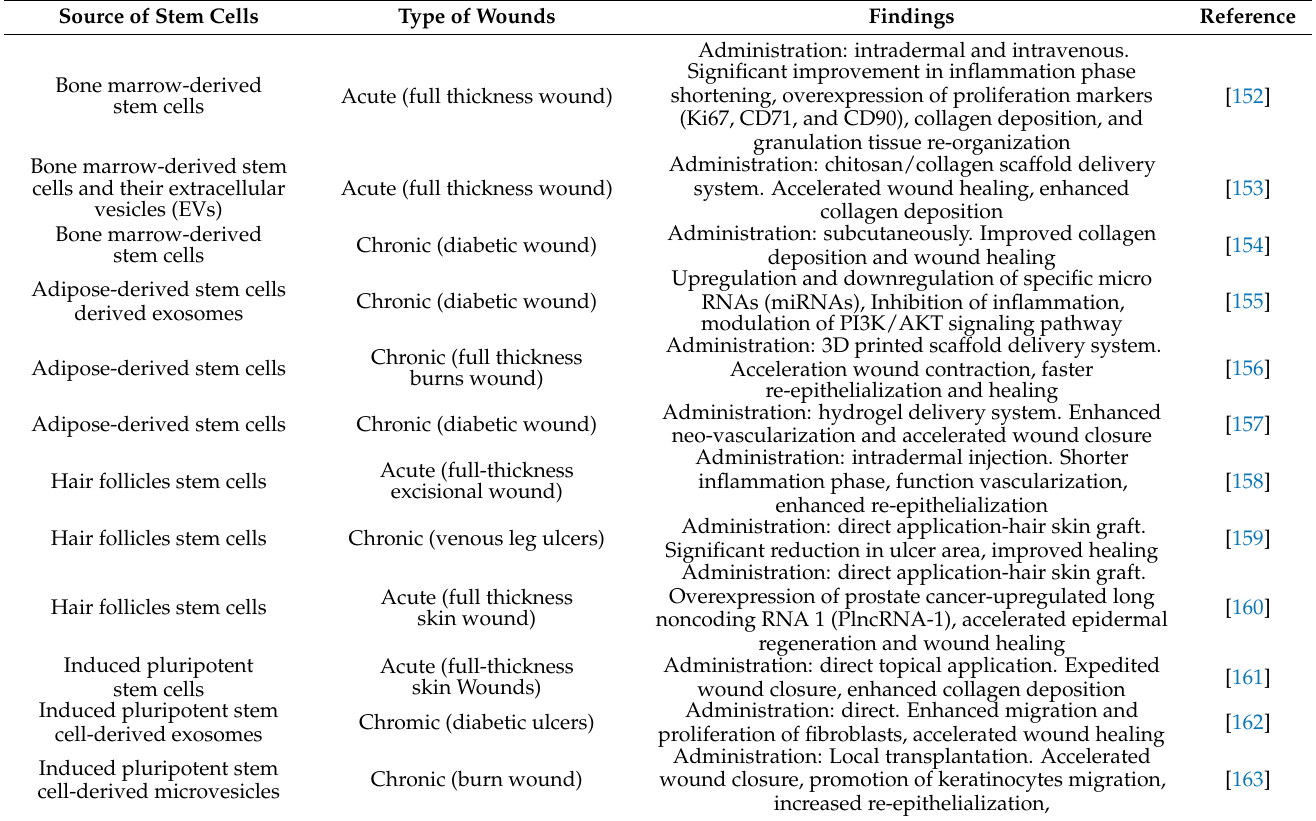
Table 2. A representative list of different stem cells-based therapies for accelerated wound